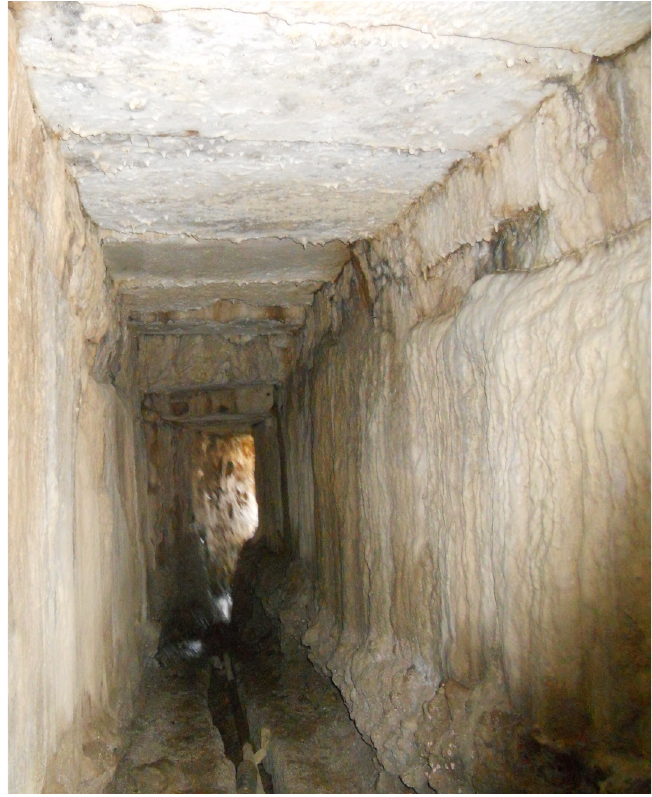
Figure 9. Tunnel with channel along the semicircular tower of the Hellenistic wall [20].